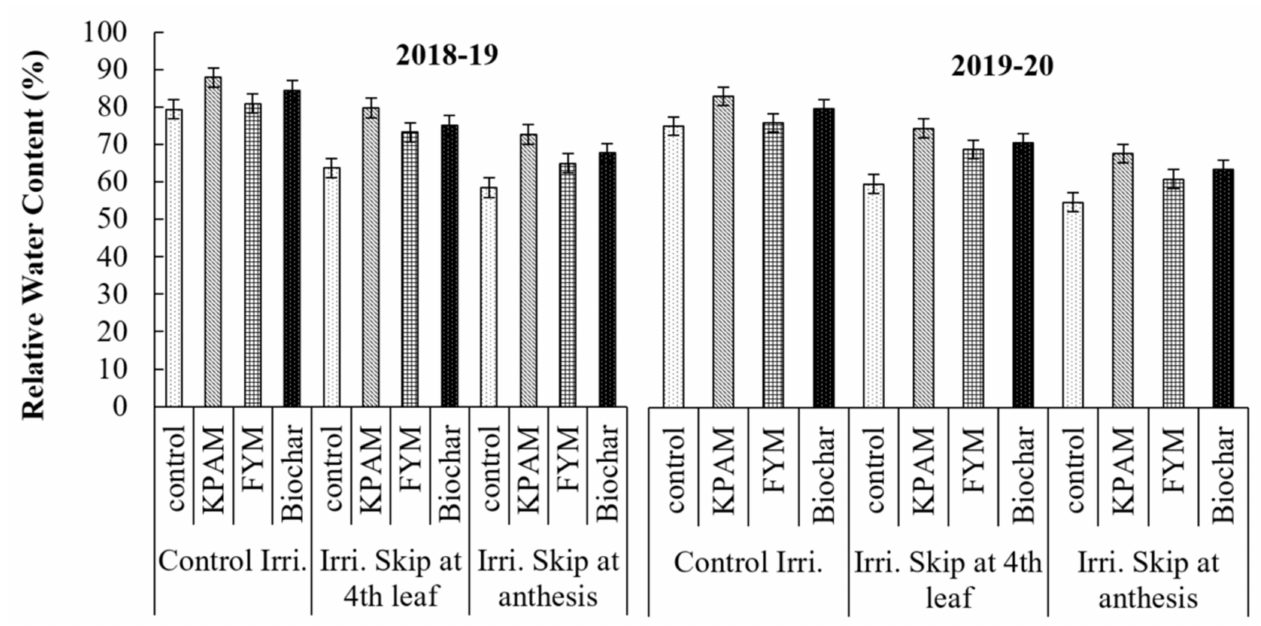
Figure 4. Effect of soil amendment materials on relative water content in the wheat crops grown under normal and water stress imposed by skipping irrigation at 4th leaf and anthesis stage of growth (mean values ± S.E).